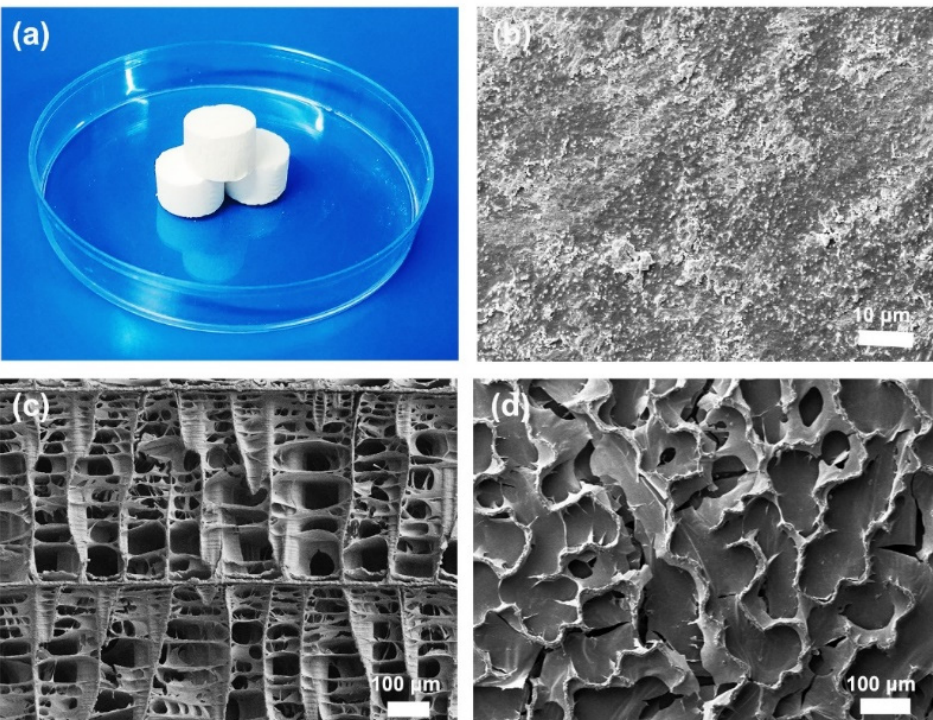
Figure 2. ( a ) Untreated cuttlebone cylinders (2 cm in height and 2 cm in diameter), ( b ) SEM image of the internal surface of an untreated cuttlebone sample, ( c ) SEM image of the cross section of an untreated cuttlebone sample cut longitudinally, ( d ) SEM image of the cross section of an untreated cuttlebone sample cut transversely.